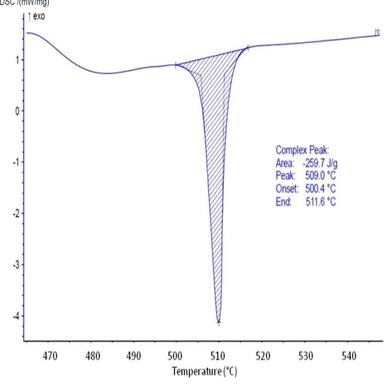
DSC results for H500 molten salt PCM freeze and melt profile.